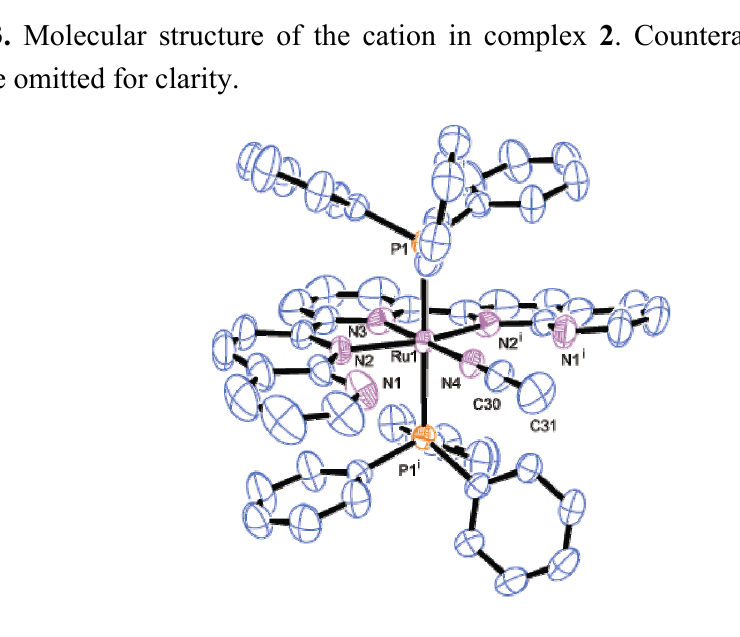
Figure 4. Molecular structure of the cation in complex 3 . Counteranions and hydrogen atoms are omitted for clarity.